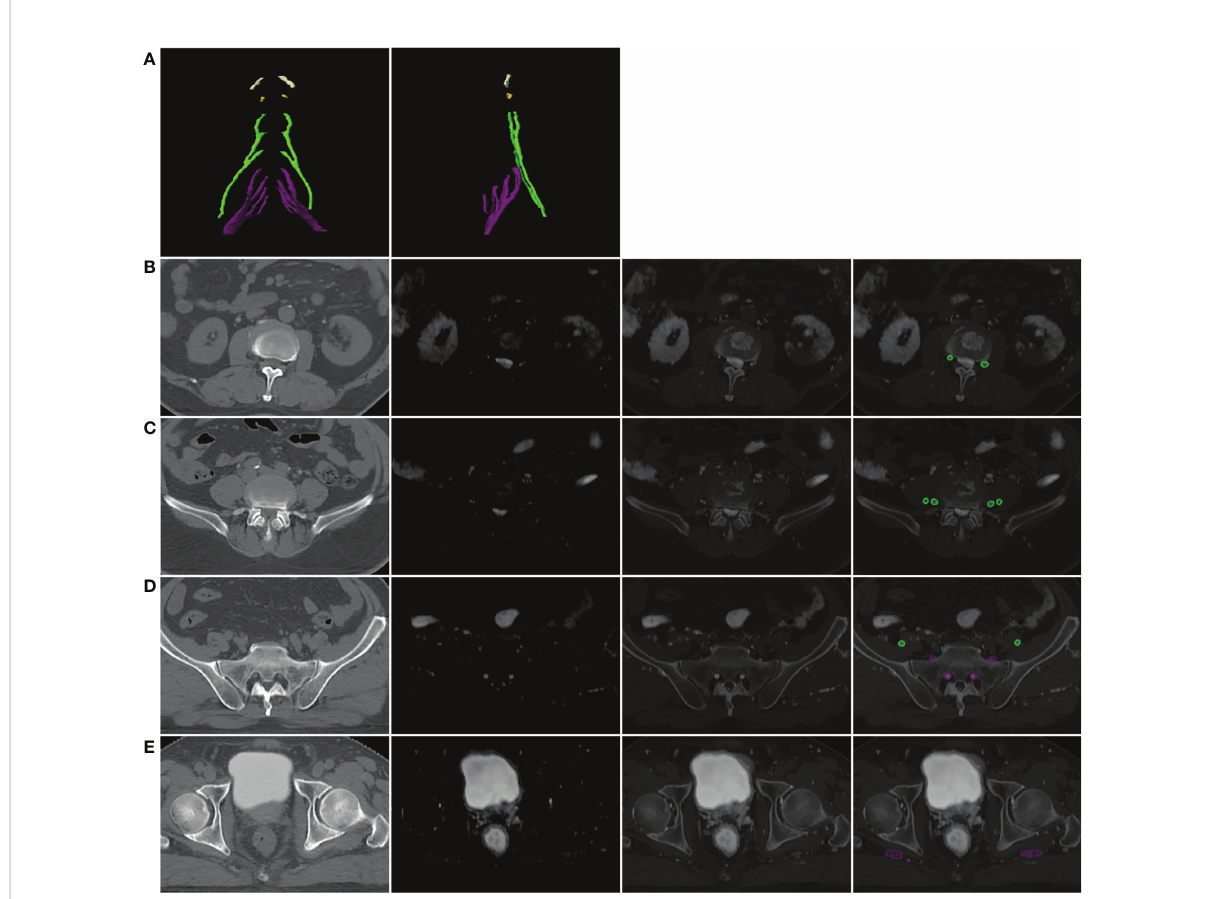
FIGURE 2 Example of the lumbosacral plexus (LSP) in three-dimensional (3D) and axial views. (A) LSP in the 3D view: white, T12 nerve root; yellow, L1 nerve root; green, L2 – L4 nerve roots and femoral nerve; purple, L5 – S3 nerve roots and sciatic nerve. (B – E) Axial view of the LSP on the level of L2 intervertebral foramina (B) , L4 intervertebral foramina (C) , sacrum (D) , and the femoral head (E) . The fi rst column presented the original simulation CT images. The second column presented deformed MR in the axial view. The third column presented the automatically registered CT and deformed MR images on Eclipse with the display ratio adjusted to a state in which the nerves “ light up ” on the fusion images. The last column presented the contours of nerves on fusion